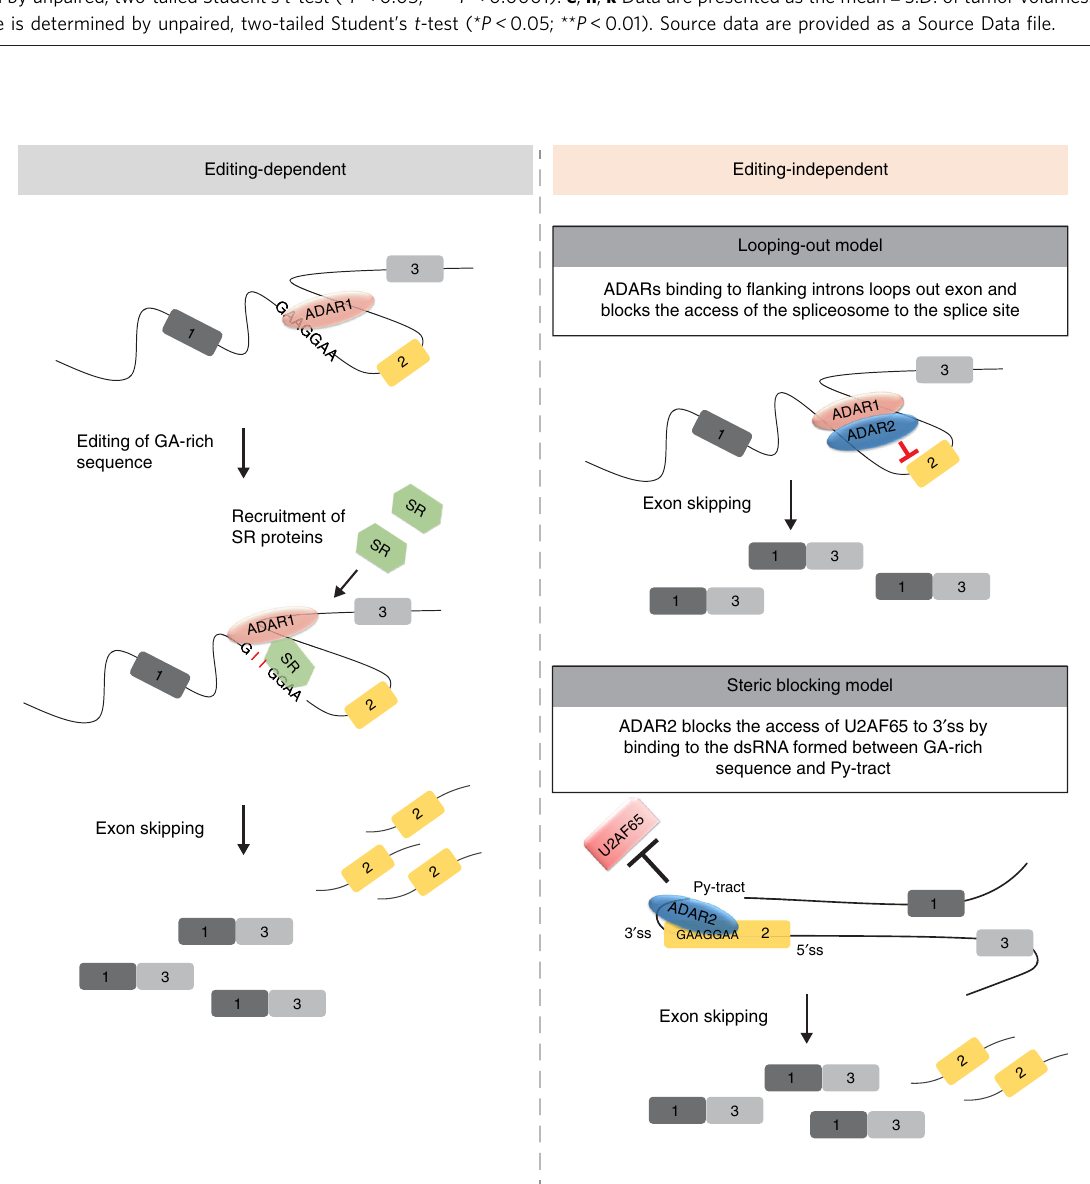
Fig. 8 ADARs-mediated splicing changes affect tumorigenesis. a , b RT-PCR analysis of CCDC15 -ex9 a or RELL2 -ex3 b splicing pattern in 12 representative matched pairs of primary ESCC and NT samples. Patients demonstrating ≥ 1.5-fold higher expression of ADAR1 or/and ADAR2 in tumors than their matched NT tissues were classi fi ed as ADAR(1/2) high group; while the remaining cases were included into ADAR(1 and 2) normal/low group. Patients demonstrating ≥ 1.5-fold higher expression of ADAR2 in tumors than their matched NT tissues were classi fi ed as ADAR2 high group; while the remaining cases were included into ADAR2 normal/low group. Tumor samples with >5% increase in exon inclusion as compared to NT samples were de fi ned as inclusion up group; while tumor samples with >5% decrease in exon inclusion as compared to NT samples were de fi ned as inclusion down group. Red, blue, and gray lines indicate inclusion up , inclusion down , and no change cases, respectively. c , f , i Quanti fi cation of foci formation induced by the indicated cells ( n = 2 or 3 biological replicates for each). Scale bar, 1 cm. d , g , j Quanti fi cation of colonies formed in soft agar induced by the indicated cells ( n = 2 or 3 biological replicates for each). Scale bar, 200 µ m. e , h , k Representative image of xenograft tumors derived from the indicated cells ( n = 7 e , 6 h , or 5 k mice per group) at end point (left panel). Growth curves of tumors derived from the indicate cells are shown in right panel. c , d , f , g , i , j Data are presented as the mean ± S.D. of biological replicates from a representative experiment. Each dot represents a biological replicate. Statistical signi fi cance is determined by unpaired, two-tailed Student ’ s t -test (* P < 0.05; **** P < 0.0001). e , h , k Data are presented as the mean ± S.D. of tumor volumes. Statistical signi fi cance is determined by unpaired, two-tailed Student ’ s t -test (* P < 0.05; ** P < 0.01). Source data are provided as a Source Data fi le.